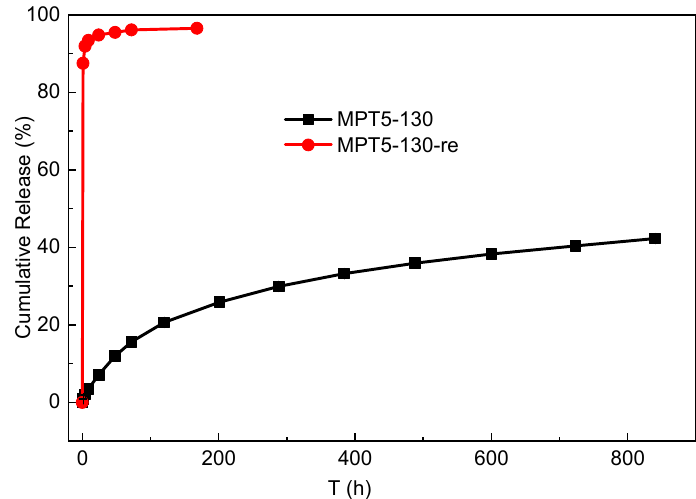
Figure 8. Cumulative release of MPT from the MPT5-130 after heat treatment.